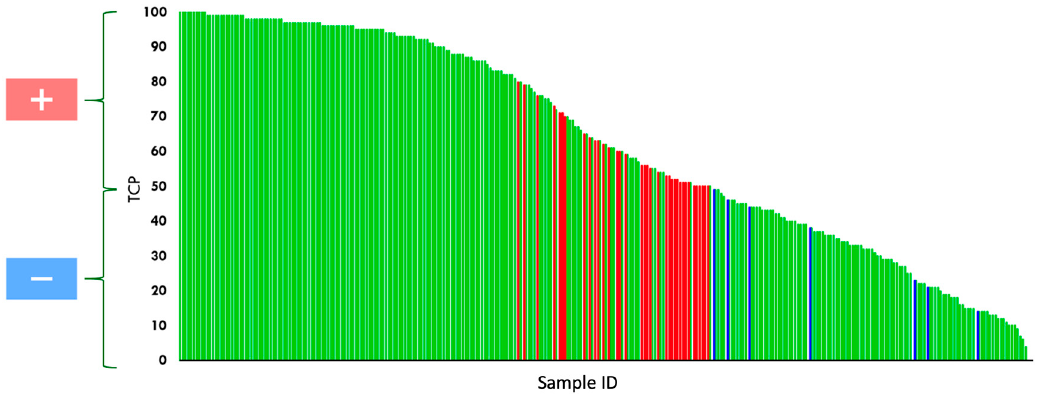
Figure 1. Results of the 311 PESI-MS analyses. Results concordant with the pathologist’s diagnosis are reported in green ( n = 266), false positive results in red ( n = 36), and false negative results in blue ( n = 9). For these results, the diagnostic concordance rate was 85.5%.